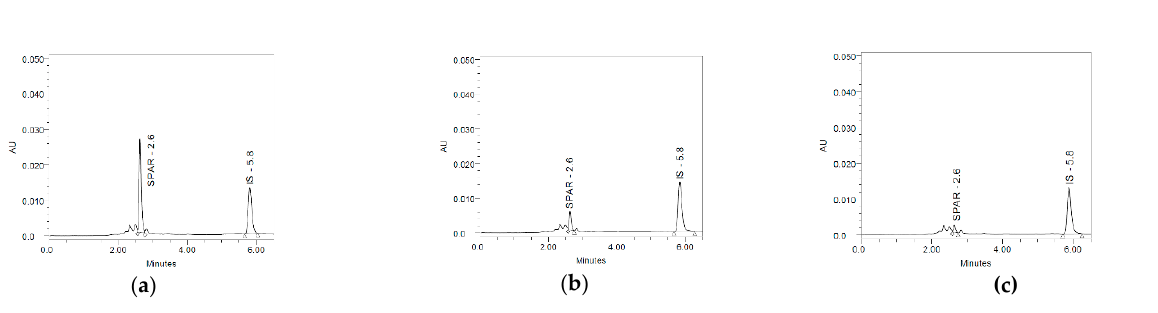
Figure 4. Representative HPLC chromatograms of sheep plasma samples after intravenous SPAR administration (5 mg/kg) at sampling times of ( a ) 15 min, ( b ) 4 h and ( c ) 24 h.